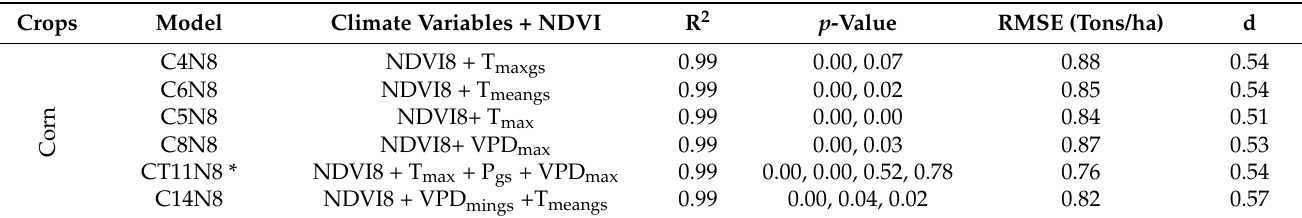
Table A3. The list of multiple linear regression models constructed with climate variables, NDVI, and corn yields of corn, sorghum, alfalfa, and wheat for a time scale of 32 years